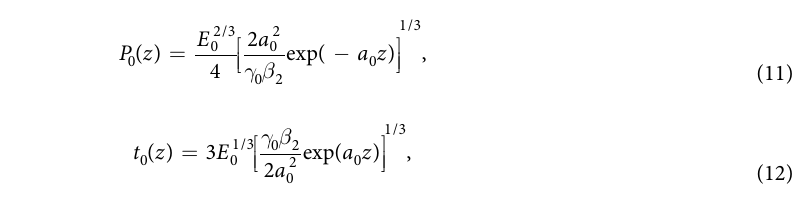
In the asymptotic regime, the pulse propagates self-similarly, and maintains its parabolic shape with the expo- nential scaling of the peak power P 0 ( z ) and pulse width t 0 ( z ) as